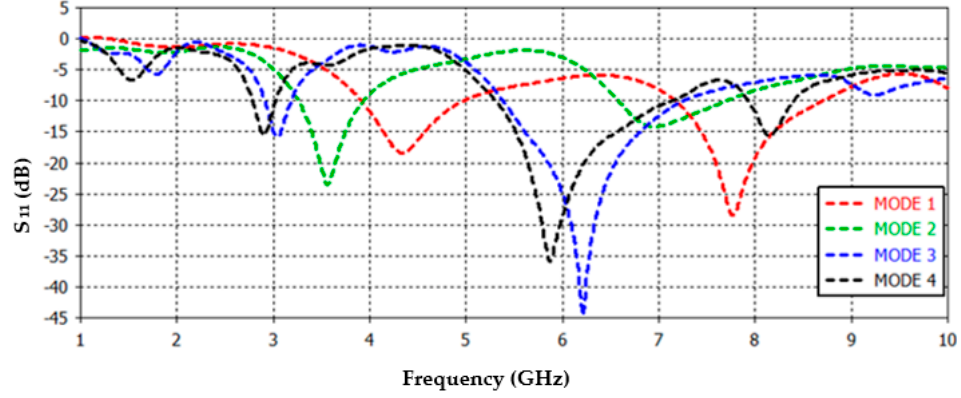
Figure 6. S 11 for all operating modes in the antenna.